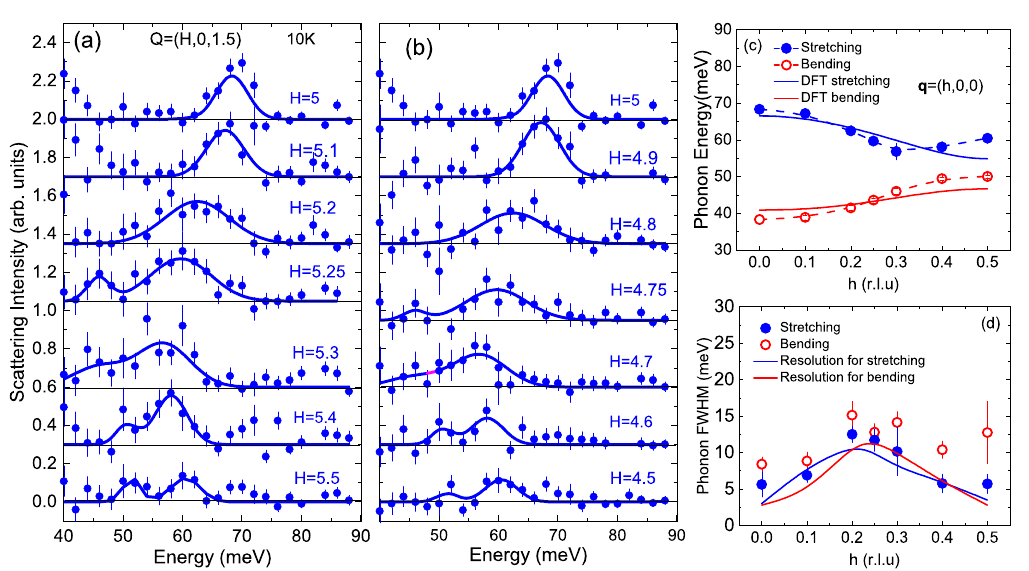
Figure 3. Zone-center bond-stretching phonon. ( a , b ) Solid line is the result of a multizone fit (see text) to the background-subtracted data (symbols). ( c ) Integrated intensity of the phonon at different wavevectors compared with the prediction based on the eigenvector shown in ( d ). ( d ) Eigenvector of the bond-stretching phonon. Small black circles represent Cu ions, large blue circles represent O. Arrows represent the phonon eigenvector drawn to scale. The eigenvector was extracted from phonon intensities in ( a , b ). (From Ref. [9]).